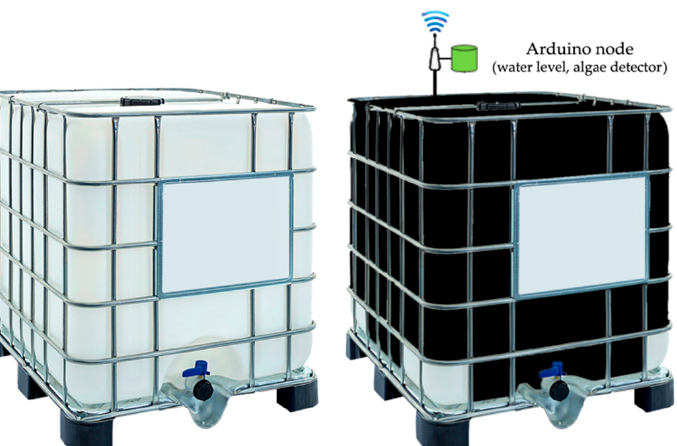
Figure 8. IBC tote ( left ), wrapped in black foil to block sunlight and suppress algae growth ( right ). Water level and algae growth can be monitored using a device based on an Arduino microcontroller and appropriate biosensor [34], adapted to wirelessly send data over the local network or the Internet to the main computer. These data can be stored in a database (DB), combined with other types of information such as those from the local weather station or historical weather data, and subsequently used to train AI models intended to automate homestead water management.